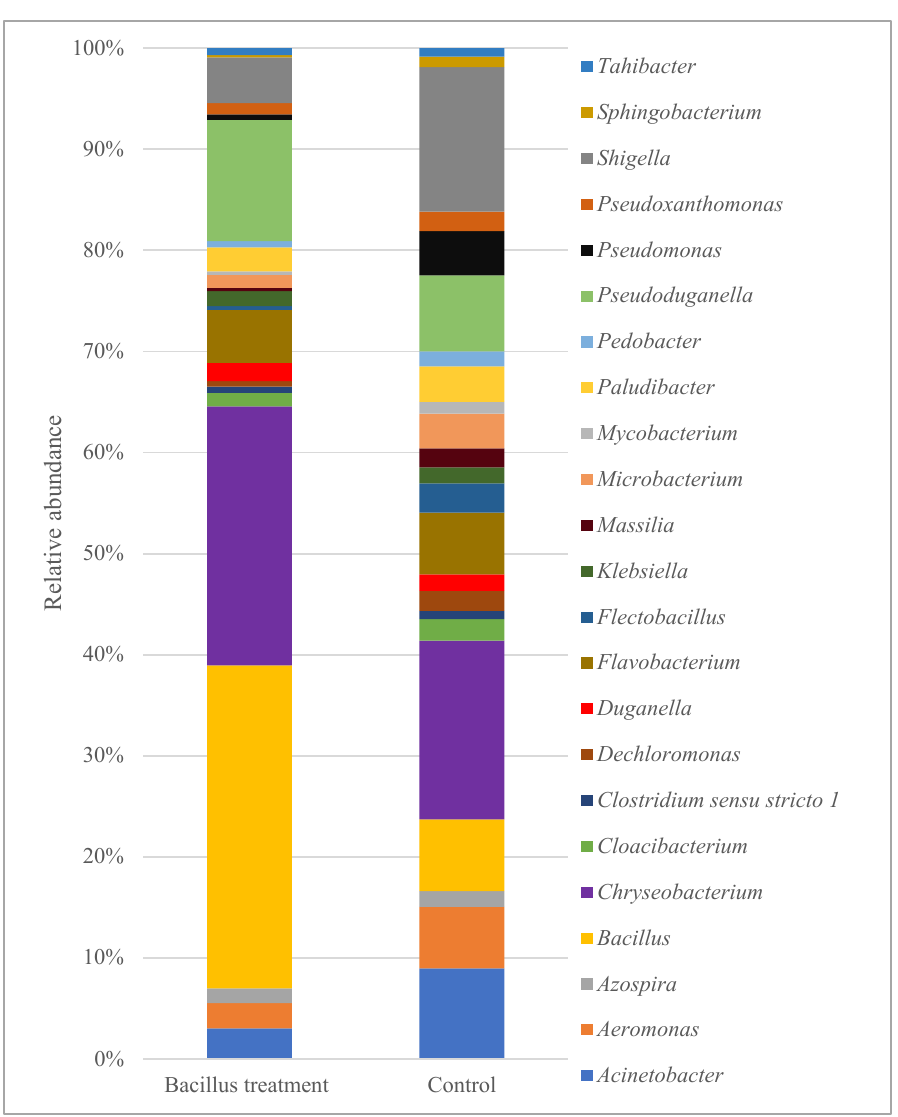
Figure 3. The average relative abundance of bacterial genera of leaf epiphytic bacterial communities of lettuce plants obtained from Bacillus probiotic treated and control systems. Genera representing greater than 0.5% of the total reads in at least one sample are presented.